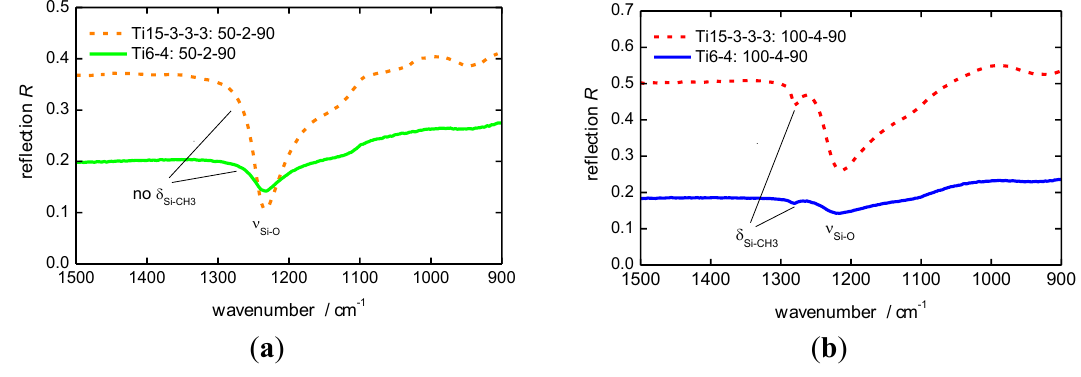
Figure 6. Crack propagation of pre-treated titanium samples (sample nomenclature: Ti-15-3-3-3 = Ti 15 V 3 Cr 3 Sn 3 Al, Ti-6-4-Ti = 6Al4V, 50 (nominal thickness [nm])–2 (working distance [cm])–90 (tilting angle/sample